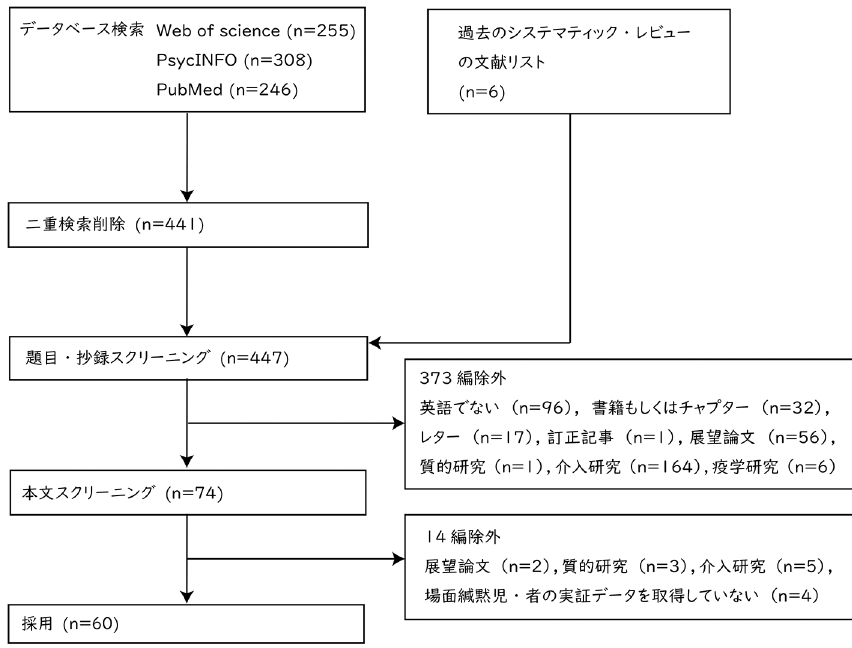
Figure 1. PRISMA に 基 づいた 論 文 選 定 フロー